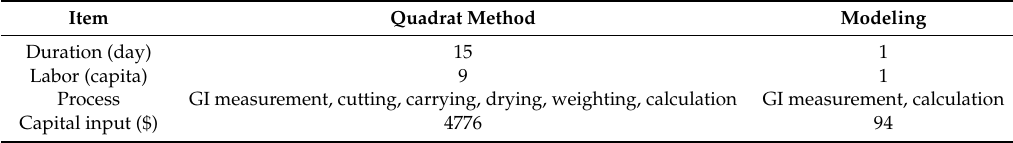
Table 7. Comparison between quadrat method and Modeling